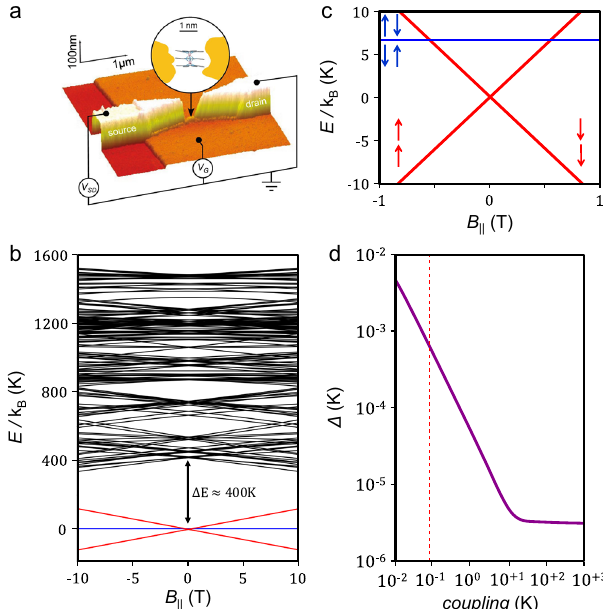
Fig. 1 Geometry of the Tb 2 Pc 3 single-molecule transistor and its electronic structure. a AFM coloured image of Tb 2 Pc 3 SMM connected to a gold source and drain electrodes through tunnelling barriers, on top of Au/HfO 2 gate (adapted from ref. 54 ). The experimental set-up allows us to control the gate potential V G and the source-drain potential V SD , while performing lock-in measurements through the latter. An enlarged picture of the Tb 2 Pc 3 SMM is given in Supplementary Fig. 1. b Zeeman diagram of Tb 2 Pc 3 SMM derived from Eq. (3) with the applied magnetic fi eld B along the easy axis of the magnetisation the ferromagnetic and antiferromagnetic basic states are respectively represented in red and blue with separation of Δ E (cid:1) 400 K from the fi rst excited state. c Enlargement of the ground ferromagnetic state and the fi rst excited state (antiferromagnetic) un red and blue, respectively. d Evolution of the energy gap Δ m ; m 0 at the anti- crossing as a function of the coupling between the electronic spins of the two terbium ions. The red dashed line marks the Δ m ; m 0 ¼ 0 : 6 mK and the ferromagnetic coupling C = 92 mK, values employed for simulations (Supplementary